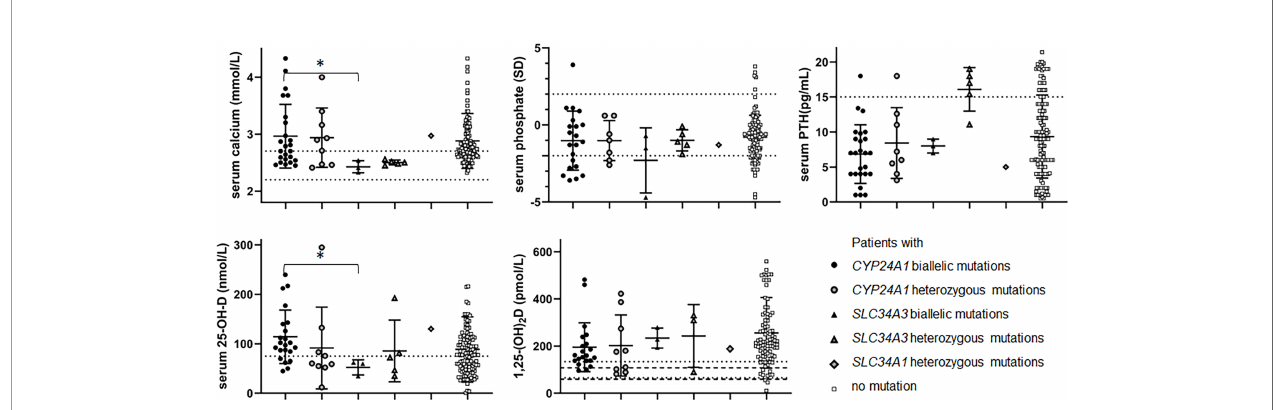
FIGURE 2 | Biochemical data according to genotype: serum calcium (mmol/L), serum phosphate (SD), PTH (pg/mL) 25-OH-D (nmol/L) and 1,25-(OH) 2 D (pmol/L). Black dot: patients with biallelic CYP24A1 mutations. Grey dot: patients with heterozygous CYP24A1 mutations. Black triangle: patients with biallelic SLC34A3 mutations. Grey triangle: patients with heterozygous SLC34A3 mutations. Grey diamond: patients with heterozygous SLC34A1 mutations. White square: patients without variation. Serum calcium dot lines: normal values 2.2-2.7 mmol/L. Serum phosphate dot lines: -2-+2SD. Serum PTH dot line: 15 pg/mL. 25-OH-D dot line: 75 nmol/L. 1,25-(OH) 2 D dot and hyphen lines: approximative normal values for children and adults. *p ≤